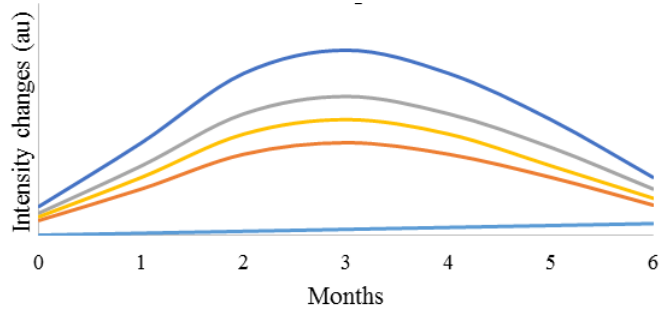
Figure 12. Schematic representation of the changes over time for the EVA materials. 0 kGy corresponds to the lowest curve and 270 kGy to the highest curve. Reproduced from [36] with the permission of Analytica Chimica Acta.